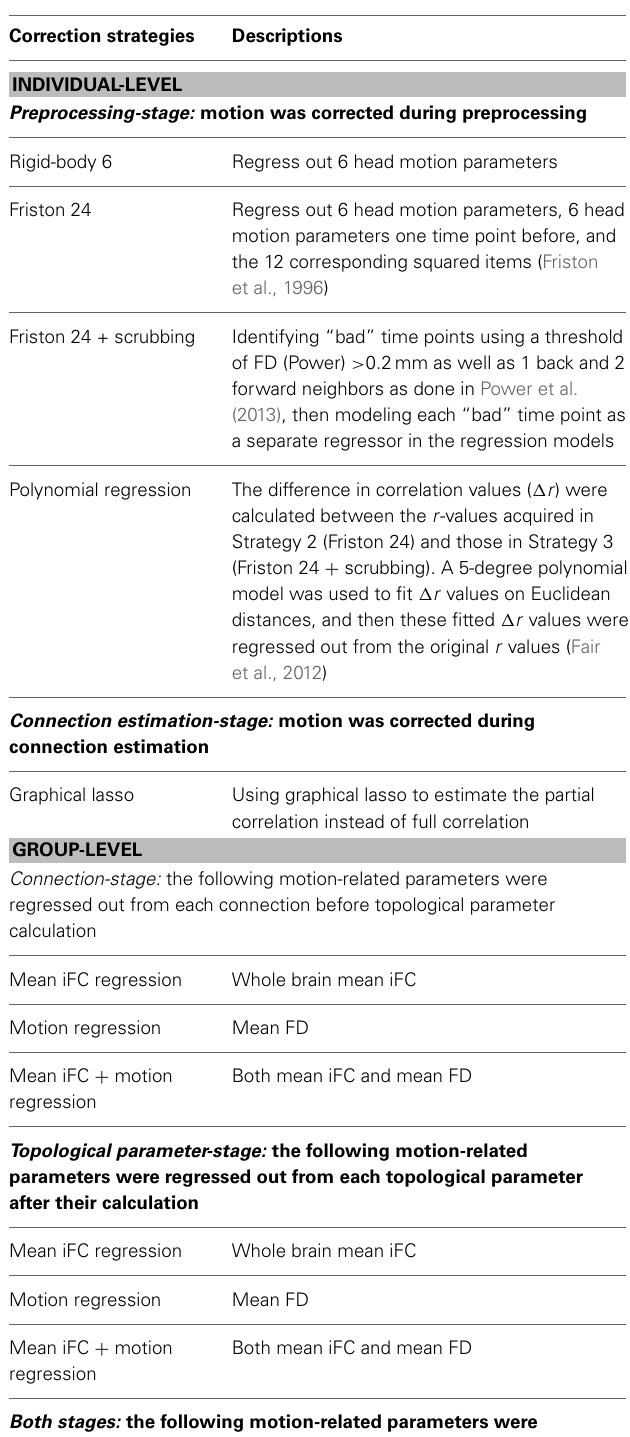
Table 2 | Head motion correction strategies investigated in the current